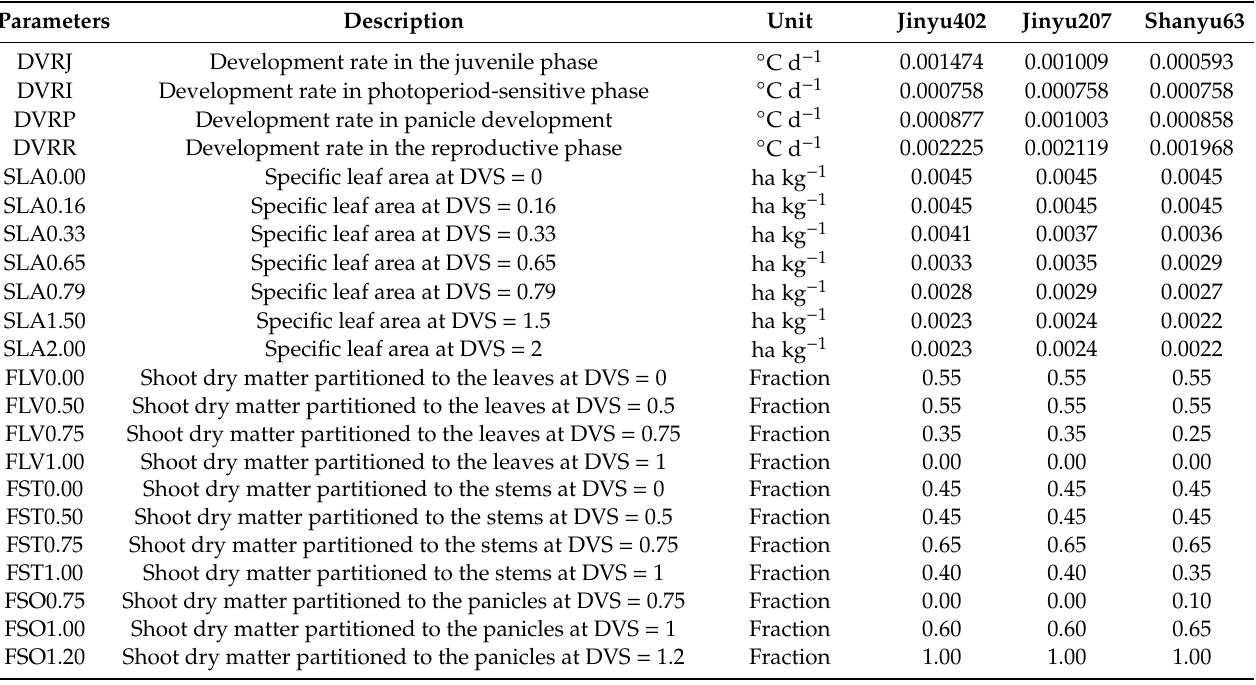
Table 3. Description and calibrated values of the selected parameters of the ORYZA v3 model.